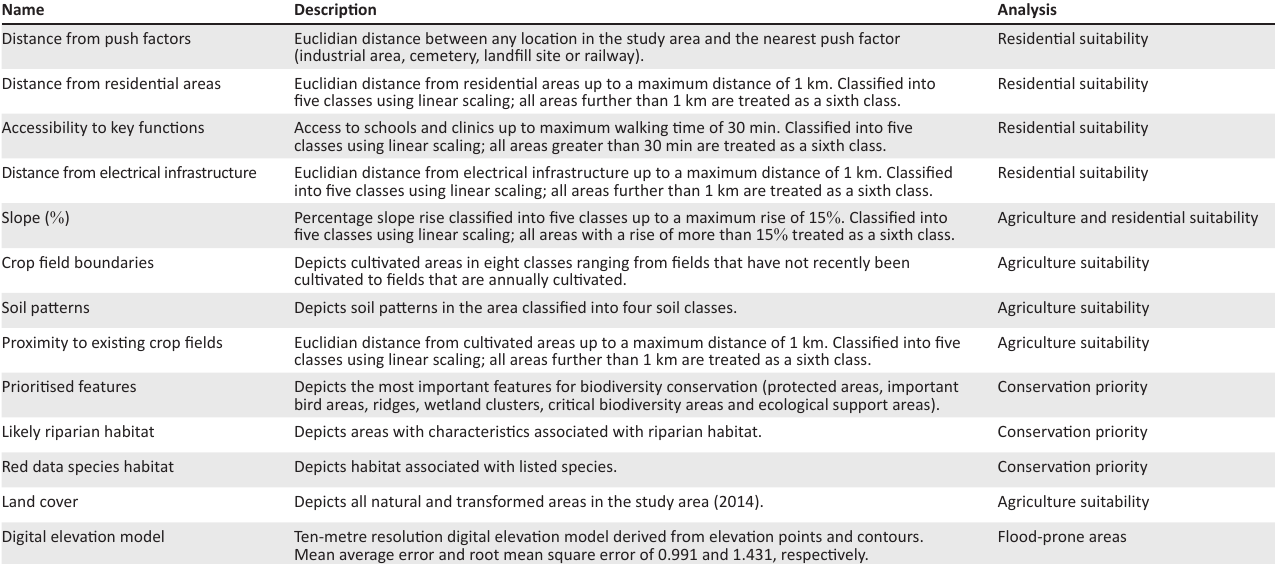
TABLE 1: Spatial data.